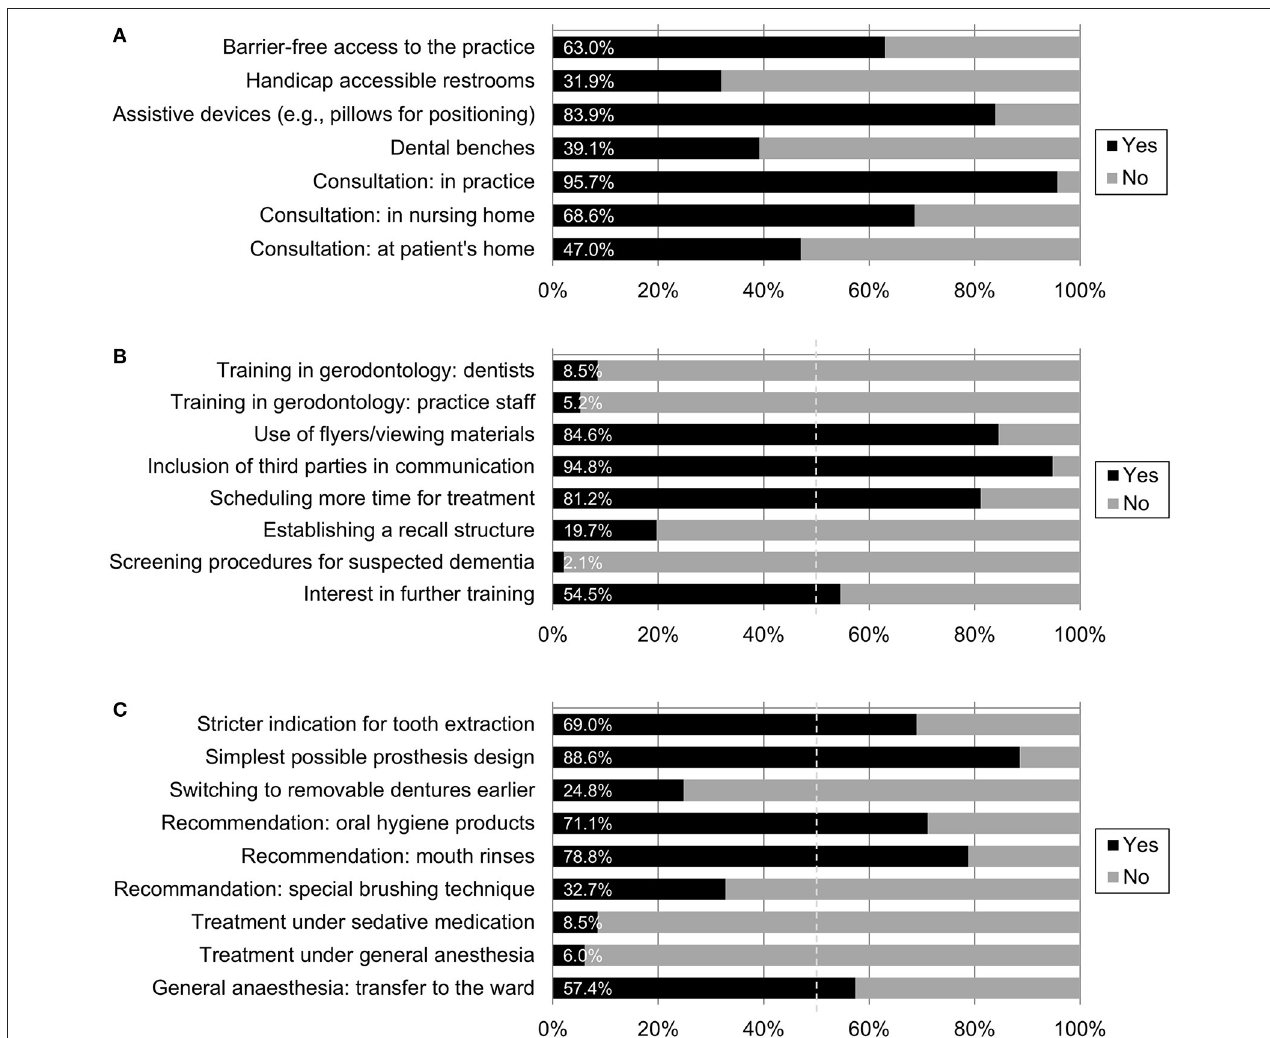
FIGURE 2 | ( A) Practice equipment and consultation. Valid percentages for seven dichotomous items (see Table 1 for formulations), n = 100–119. (B) Training and expertise. Valid percentages for eight dichotomous items (see Table 1 for formulations), n = 94 to 117. (C) Dealing with special circumstances of dental treatment. Valid percentages for nine dichotomous items (see Table 1 for formulations), n =